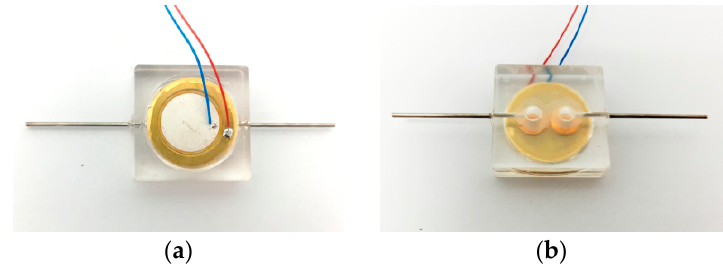
Figure 11. Photo of the prototype with elastic inlet and outlet, ( a ) top view; ( b ) bottom view. Table 1. The main parameters of